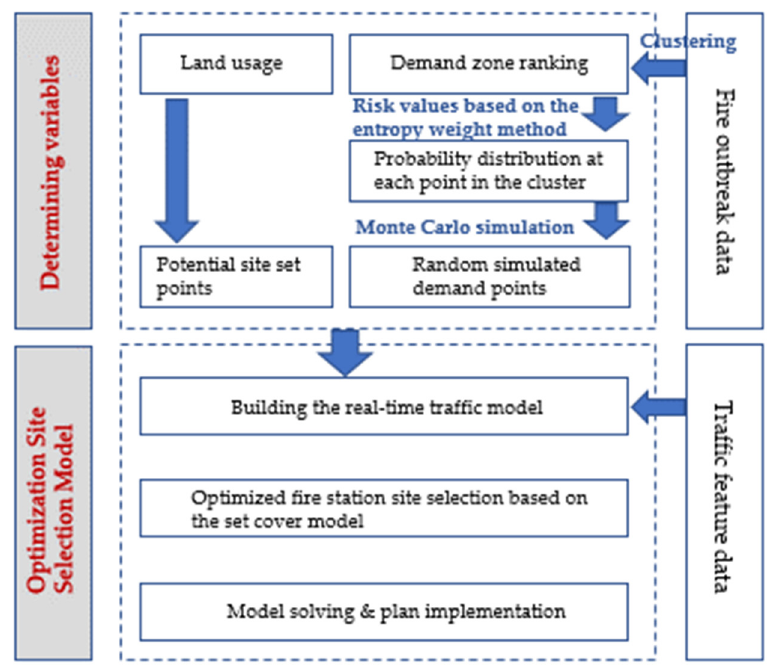
Figure 1. Workflow of our research methodology.